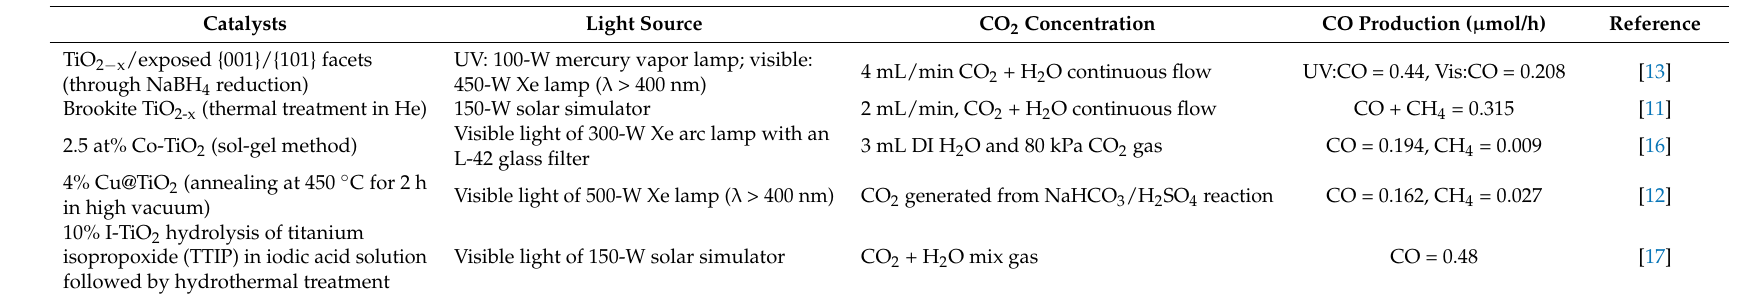
Table 1. A list of defective TiO 2 catalytic performance for CO 2